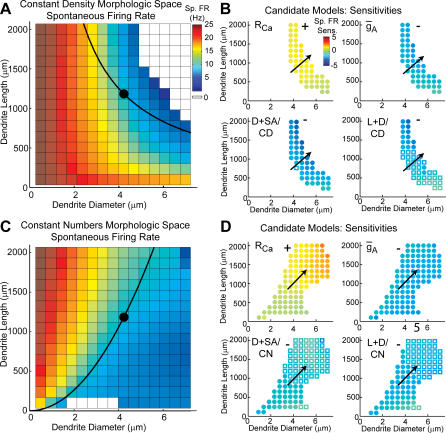
Spontaneous Firing Rate Sensitivity across Constant Density and Constant Numbers Morphologic Spaces(A) Baseline spontaneous firing rate represented as a colormap across CD morphologic space (colorscale 0–25 Hz; top right). Black dot marks the original morphology used for the conductance space searches. Thick black curve indicates all models matching the original SA.(B) Spontaneous firing rate sensitivities to perturbations of active parameters RCa and
(top row), and morphologic parameters D + SA / CD and L + D / CD (bottom row) of candidate models across the space. Arrows indicate the principal sensitivity trend to each parameter. In the bottom left of (B), filled circles indicate models for which sensitivity to D + SA / CD was greater than sensitivity to all active parameters except
. In the model shown as an open square, sensitivity to two or more active parameters was greater than sensitivity to D + SA / CD. In the bottom right of (B), filled circles and open squares likewise compare the sensitivity to L + D / CD and sensitivities to active parameters. Analogous colormaps across CN morphologic space are shown for (C) baseline spontaneous firing rate and (D) spontaneous firing rate sensitivity to parameter perturbations among candidate models. The black curve in (C) indicates all models matching the original axial resistance (see Materials and Methods). In the bottom row of (D), filled circles show models for which sensitivity to either D + SA / CN or L + D / CN was greater than sensitivities to all active parameters except
and
. In models shown as open squares, sensitivity to three or more active parameters was greater than sensitivity to either D + SA / CN or L + D / CN.